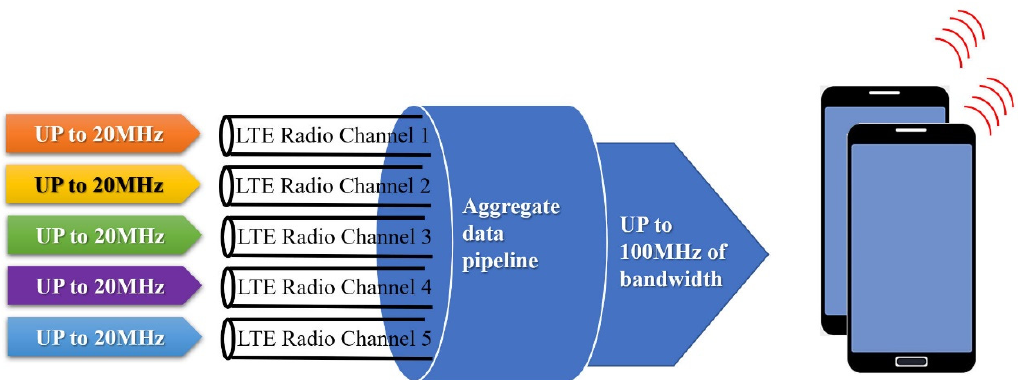
Figure 10. Schematic diagram of the five-carrier aggregation in LTE.